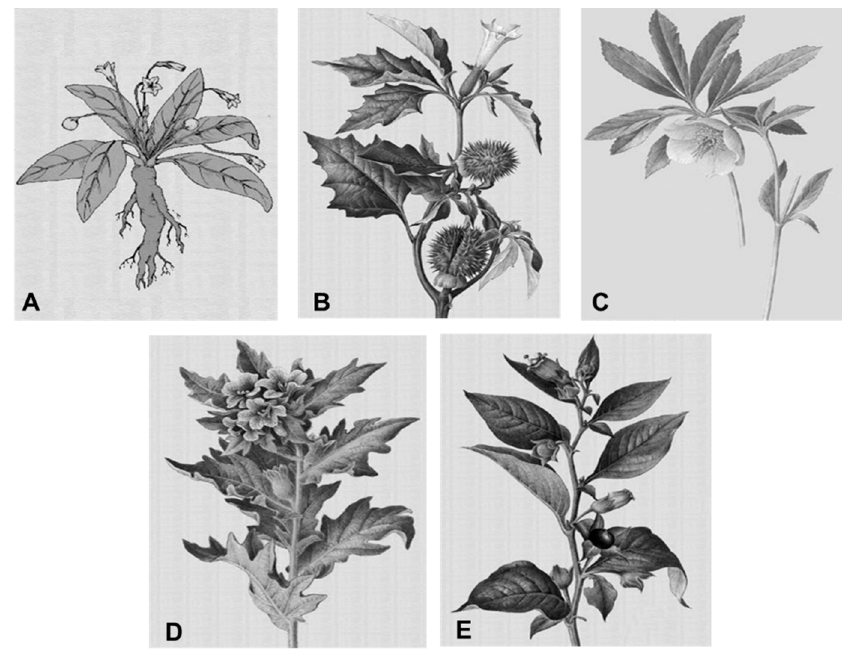
Figure 1. Illustrations of the most relevant plants in the Solanaceae family, from which several alkaloids were obtained to be used in psychiatric practice as sedatives prior to modern psychopharmacology: ( A ) Mandrake ( Mandragora officinalis ); ( B ) Stramonium ( Datura estramonio ); ( C ) Eléboro ( Helleborus niger ); ( D ) Hellebore ( Hyosciamus niger ); ( E ) Belladonna ( Atropa belladonna ).